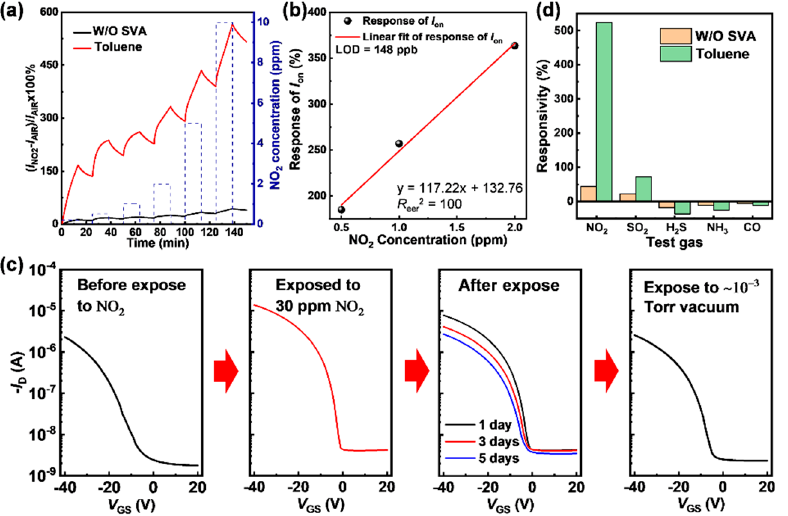
Figure 4. ( a ) The real-time responsivities of the devices to dynamic NO 2 concentration at V DS = V GS = − 40 V. ( b ) Calculation of limit of detection. ( c ) Transfer curves of the toluene-treated device when tested under different environments. ( d ) The response of the toluene-treated devices to various gases.